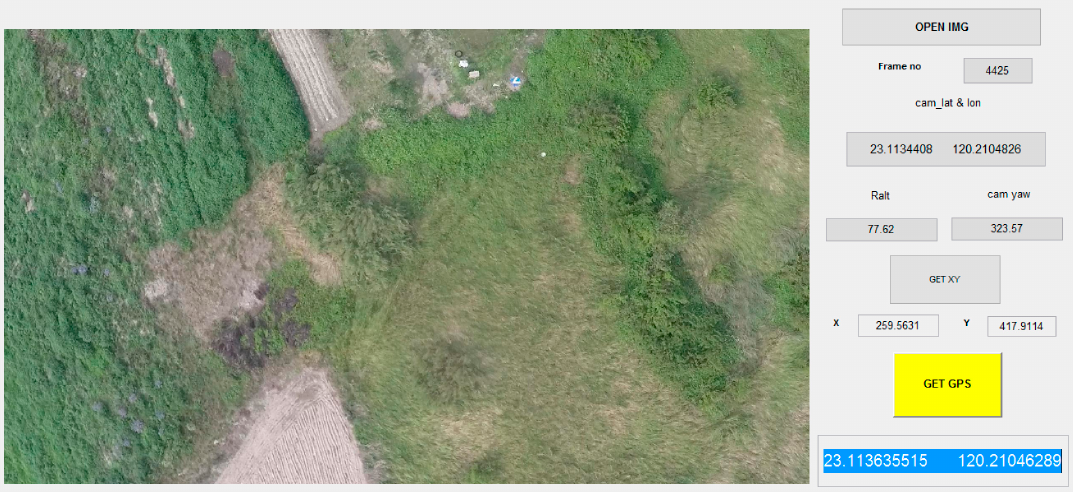
Figure 17. Graphical user interface for the GPS transformation that allows end users to access a target’s GPS coordinates using simple buttons.